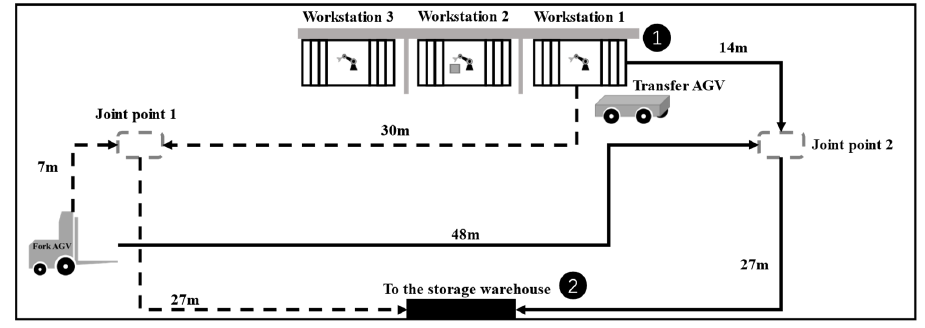
Fig. 4. The shortcoming of decoupled scheduling method.